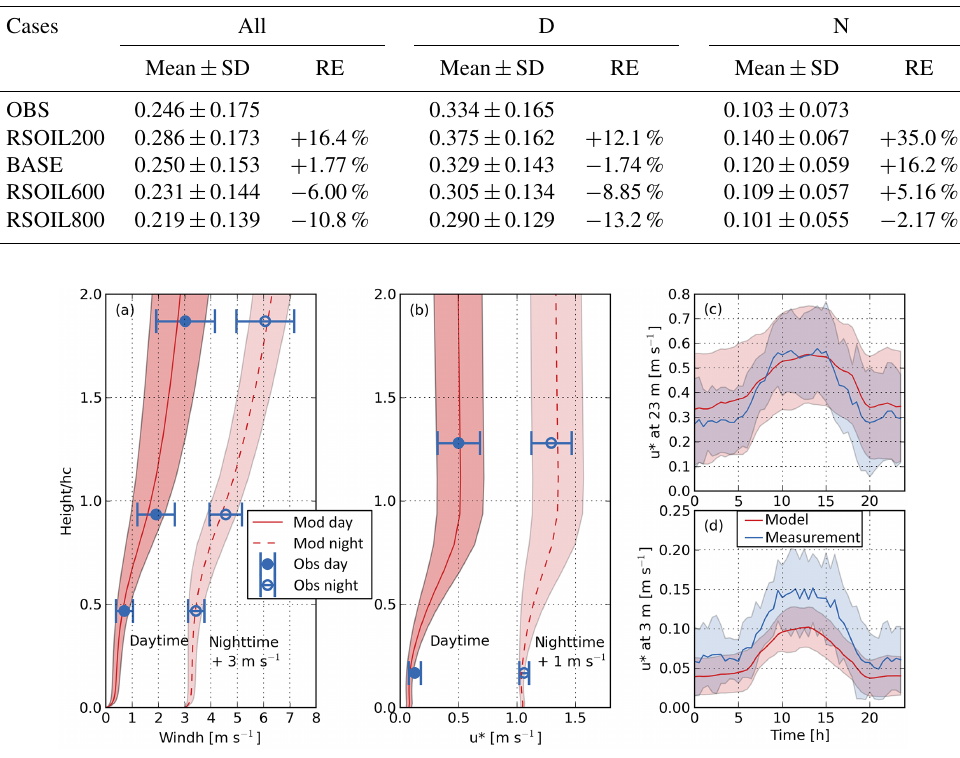
Figure 3. Modelled (red solid line for daytime, red dashed line for nighttime) and measured (blue solid circle for daytime, blue empty circle for nighttime) profiles of horizontal wind speed (windh) (a) and friction velocity ( u ∗ ) (b) . Nighttime values are shifted by 3 and 1ms − 1 for wind and u ∗ for clarity of presentation, respectively. The ranges of ± 1SD (standard deviation) of modelled and measured data are marked as shades and error bars. The height is normalised by canopy height h c . The monthly-mean diurnal cycles of modelled (red) and measured (blue) friction velocity at 23 and 3m are shown in (c) and (d) . The ranges of ± 1SD are marked as shades in the same